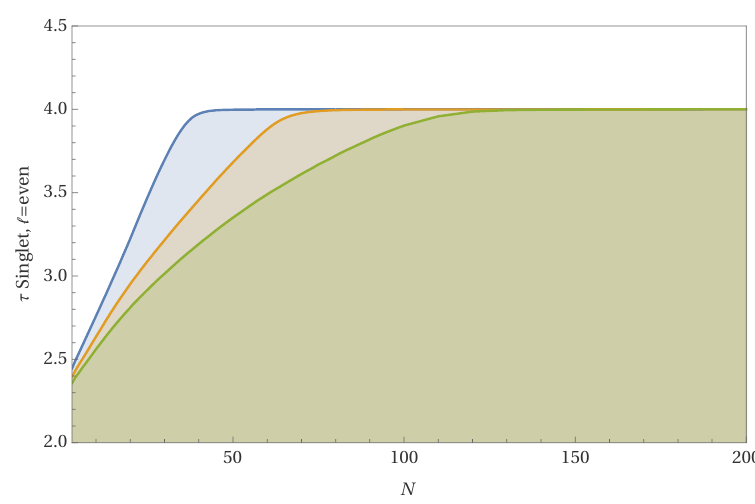
Figure 4. Upper bound for the gap on the twist of all singlets as a function of N , using the full system of correlators. The different curves are the different values of Λ = 19 , 23 , 27